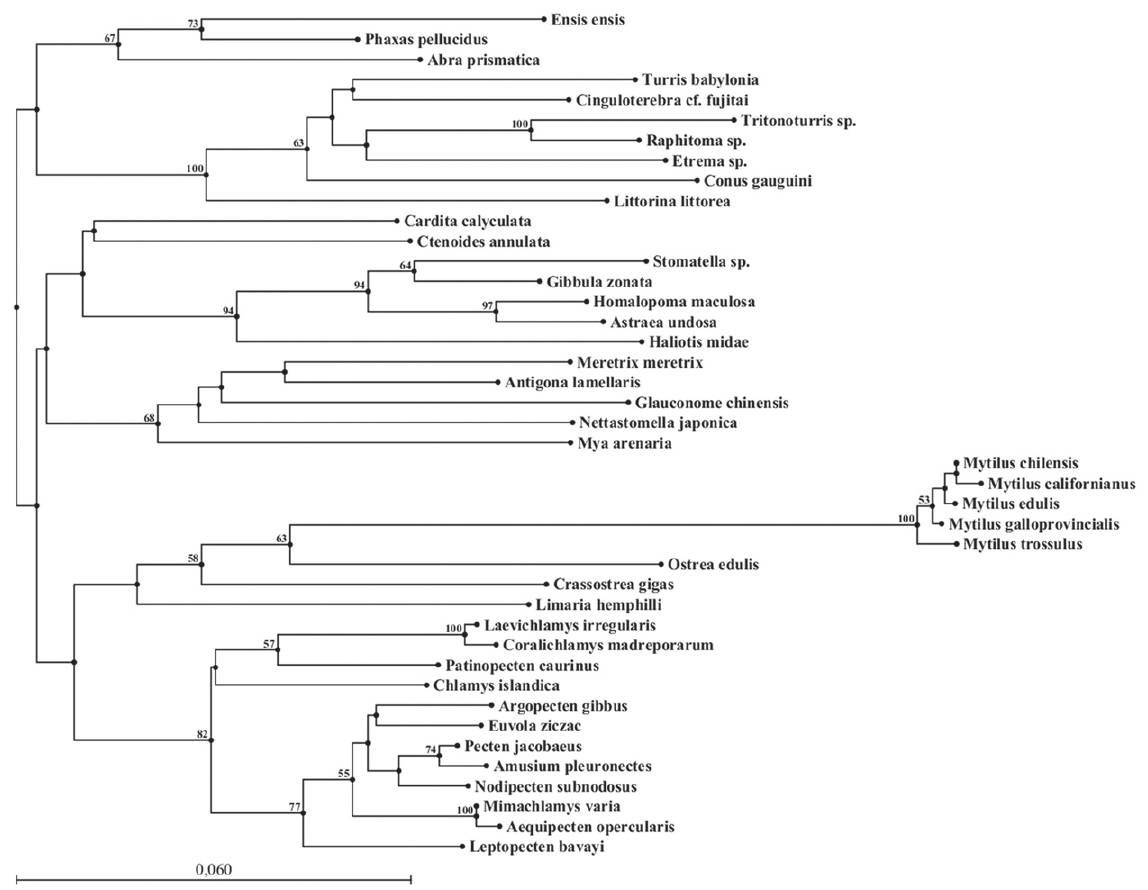
Fig. 2. The phylogenetic relationships among different molluscan species, as analysed by the Neighbour- Joining method. Bootstrap values over 50% are written above the branches. Bar =